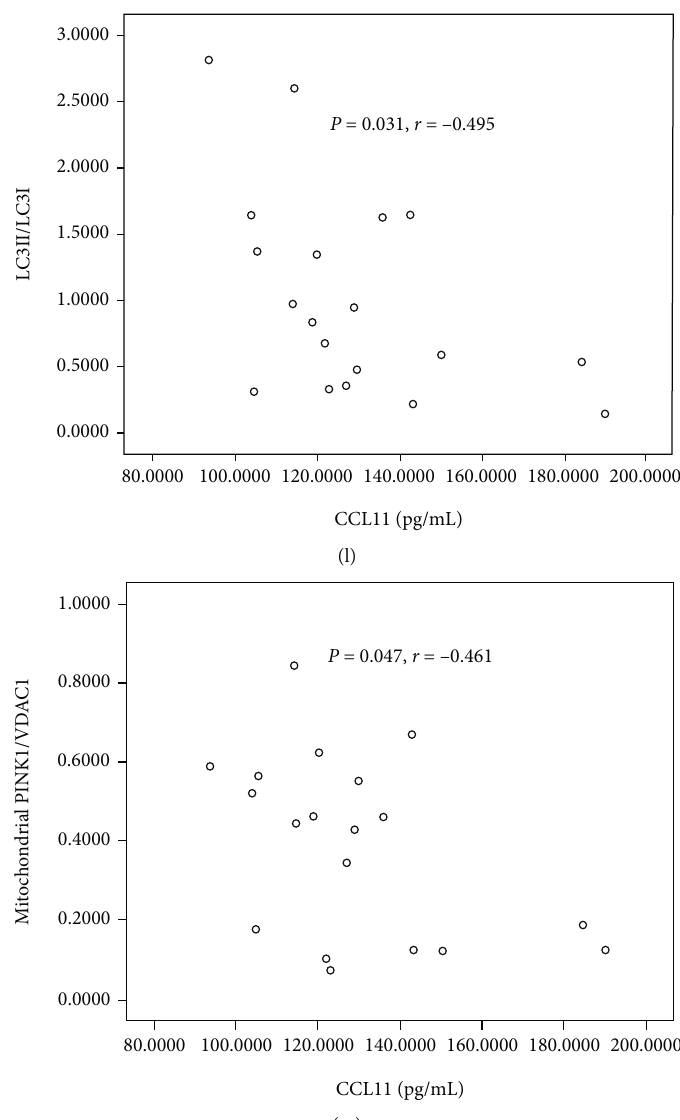
Figure 5: Cytokines in di ff erent CRSwNP subtypes. (a) IL-4 levels were increased in patients with eCRSwNP but not in those with noeCRSwNP. (b) IL-5 levels were signi fi cantly increased in the nasal polyps of patients with eCRSwNP or noeCRSwNP, compared with control tissues. (c) IL-13 levels were signi fi cantly increased in the nasal polyps of patients with eCRSwNP or noeCRSwNP, compared with control tissues. (d) ECP was upregulated in the nasal polyps of patients with eCRSwNP or noeCRSwNP, and particularly high in eCRSwNP, compared with control tissues. (e – g) Levels of the eotaxins CCL11, CCL24, and CCL26 were elevated in the nasal polyps of patients with eCRSwNP or noeCRSwNP, compared with control tissues. (h – j) In patients with eCRSwNP, LC3II/LC3I, mitochondrial PINK1, and total parkin protein levels were signi fi cantly inversely correlated with ECP levels. (k) In patients with noeCRSwNP, Beclin 1 protein levels were inversely correlated with ECP levels. (l, m) In patients with noeCRSwNP, LC3II/LC3I and mitochondrial PINK1 protein levels were inversely correlated with CCL11 levels. ∗ P < 0 : 05 , ∗∗ P < 0 : 001